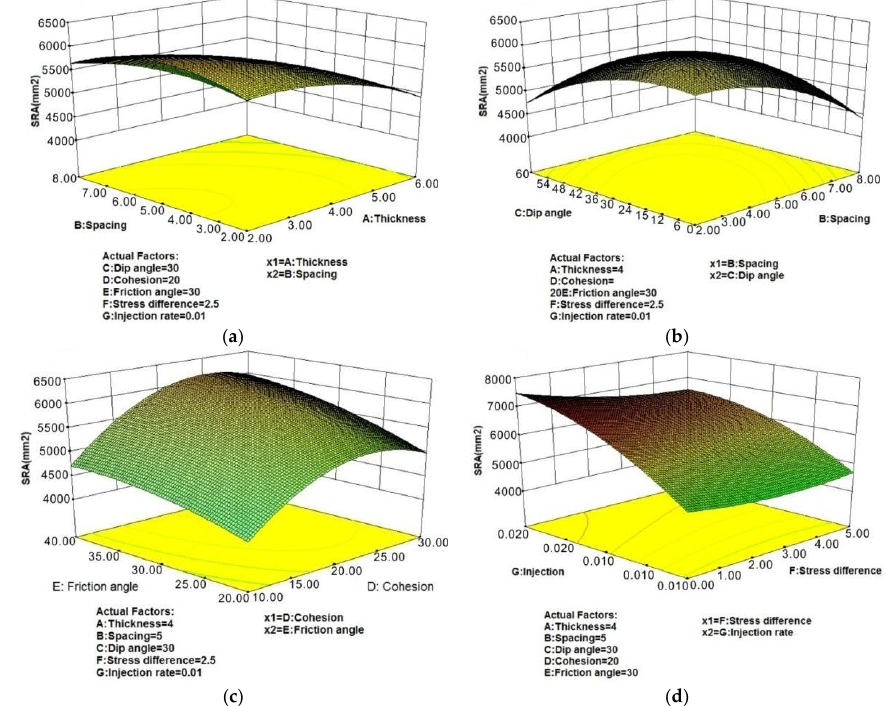
Figure 10. The influential of studied factors on SRA response surface: ( a ) plots the influence of factor A and B on SRA; ( b ) plots the influence of factor B and C on SRA; ( c ) plots the influence of factor D and E on SRA; and ( d ) plots the influence of factor F and G on SRA.